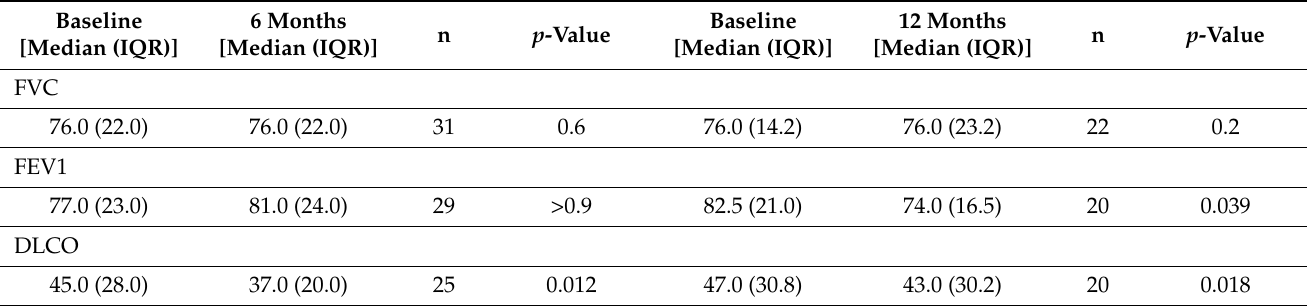
Table 1. Comparison of spirometric measurements after 6 months and after 12